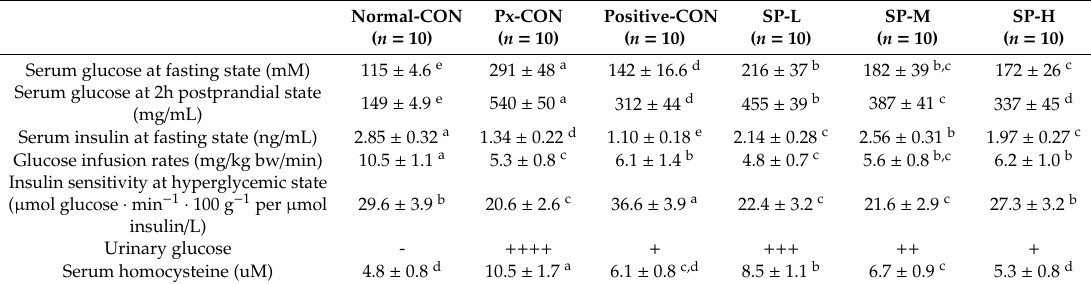
Table 2. Glucose metabolism during the hyperglycemic clamp.